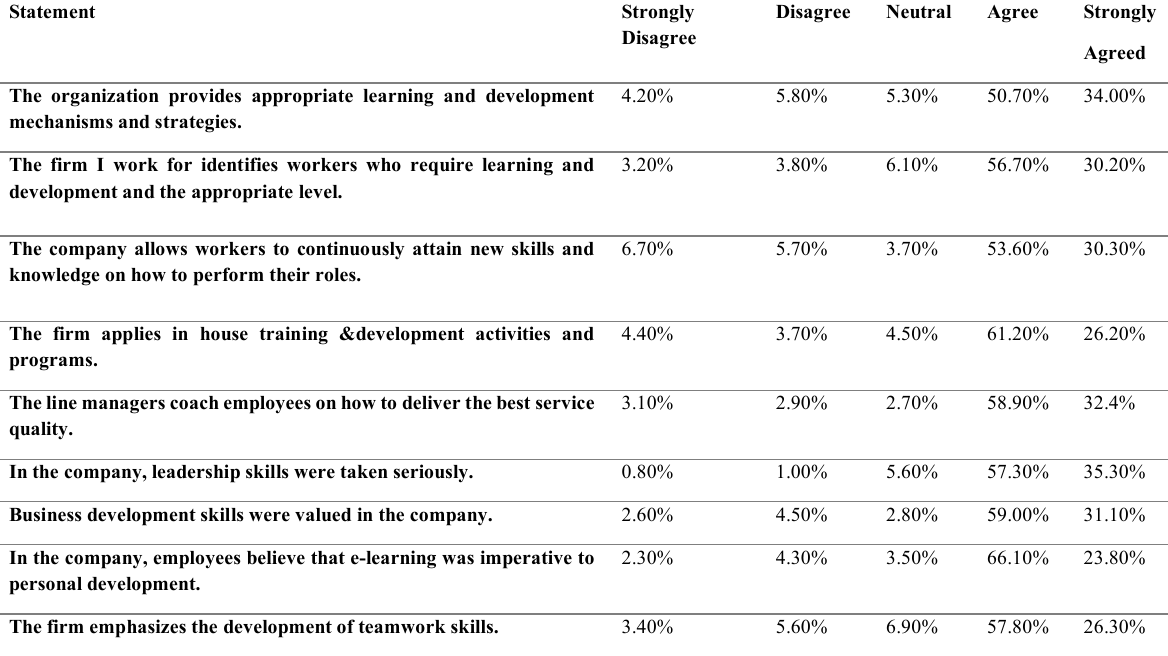
Table 1: Learning and Development